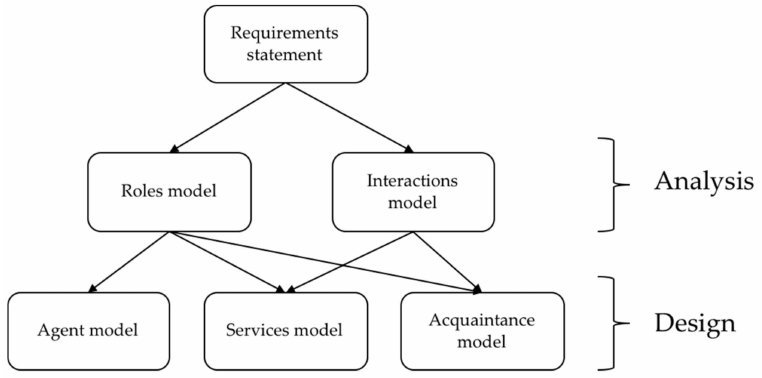
Figure 5. The conceptual framework of the Gaia methodology [111].